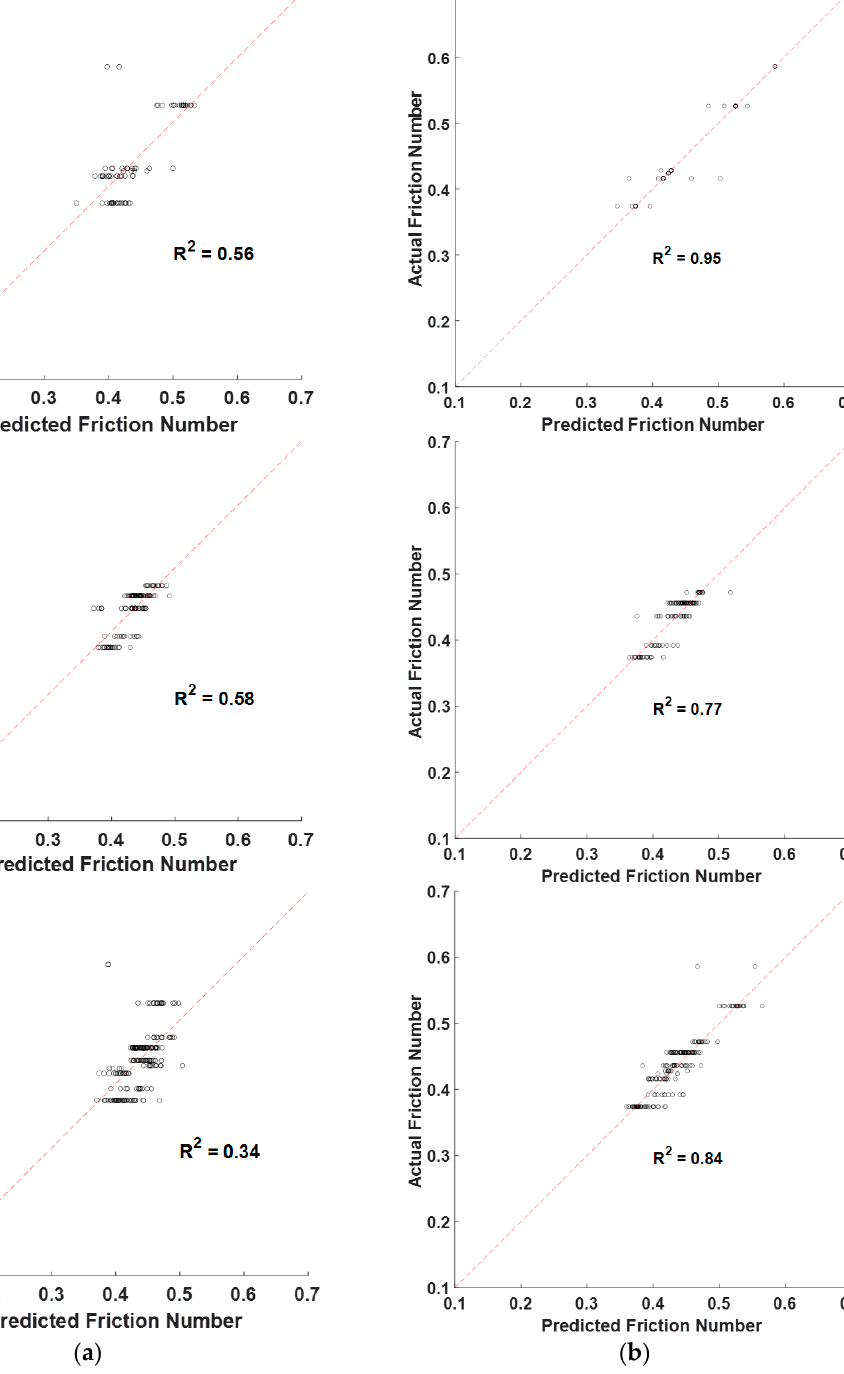
Figure 6. Validation results of friction prediction models: ( a ) MLR models, and ( b ) ANN models.